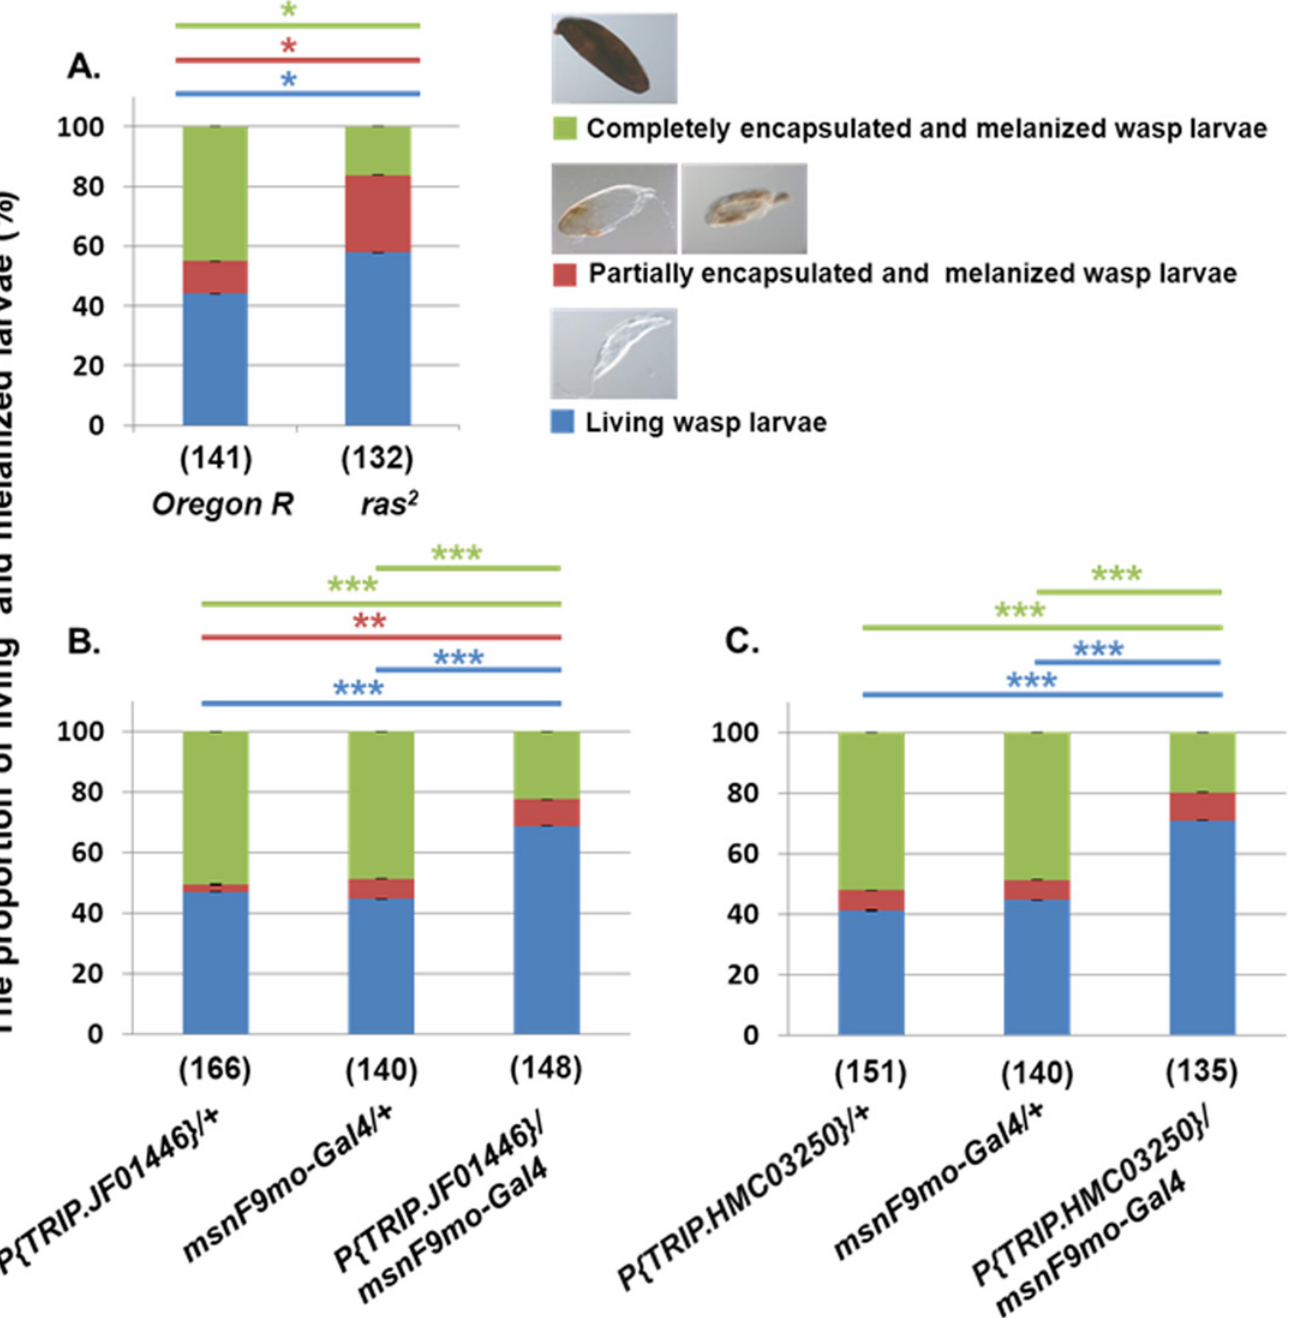
Fig 2. The phenotype and proportion of living wasp larvae, partially or completely encapsulated and melanized wasp eggs in ras 2 mutant or after RNAi silencing. (A) The phenotypic categories of L . boulardi G486 larvae and capsules in D . melanogaster larvae after parasitization. Proportion of living wasp larvae (blue) and partially (red) or completely melanized (green) capsules in the ras 2 mutant or in the Oregon-R control (B, C) and from the parental lines ( P{TRIP . JF01446}/+ , P{TRIP > HMC03250/+ and msnF9mo/Gal4/+ ) and progenies ( P{TRIP . JF01446} > msnF(mo/Gal4 and P {TRIP > HMC03250 > msnF9mo/Gal4 72h after the L . boulardi G486 infestation. The numbers in parenthesis indicate the number of the examined Drosophila larvae. The error bars indicate the standard error of the mean. * p < 0.05, ** p < 0.01, *** p <